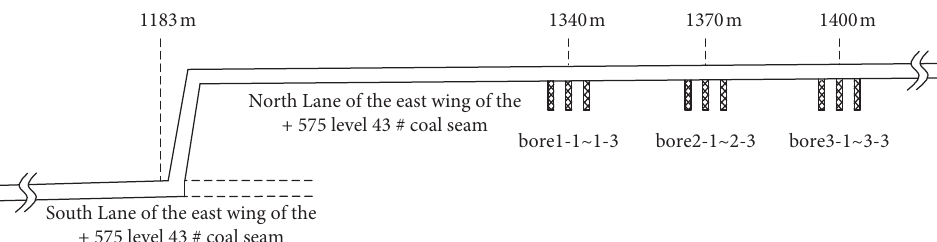
Figure 15: Layout of measuring holes in 43 coal seam.